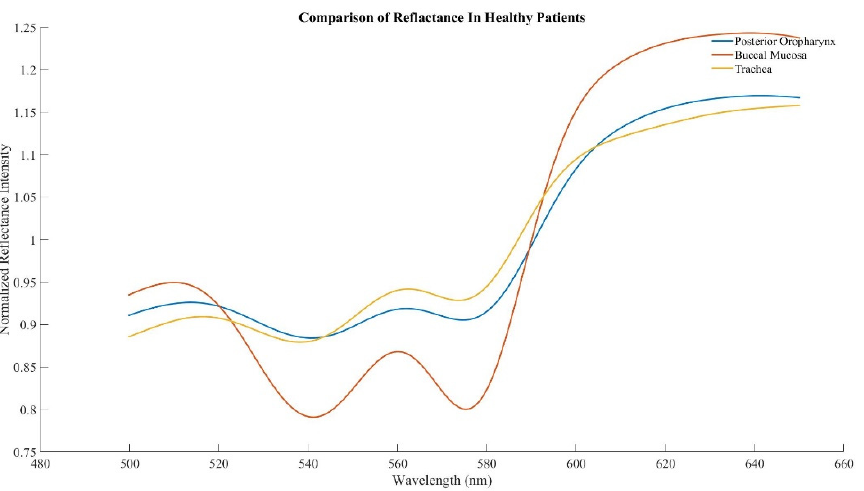
ROC curves for comparisons of trachea vs. buccal mucosa and trachea vs. posterior oro- pharynx were 0.6654 and 0.6181, respectively.